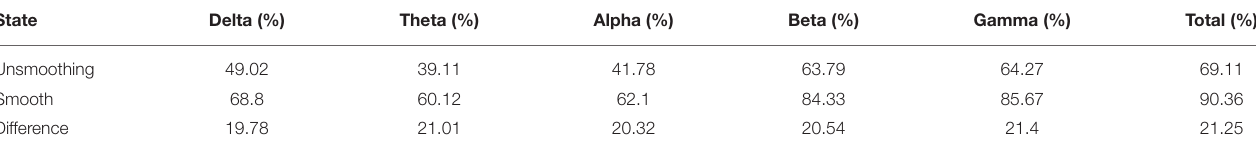
TABLE 4 | The accuracies (%) of unsmoothing and Kalman smoothing method with RASM_PSD features of 120 dimensions as inputs and SVM as a classifier from the total frequency